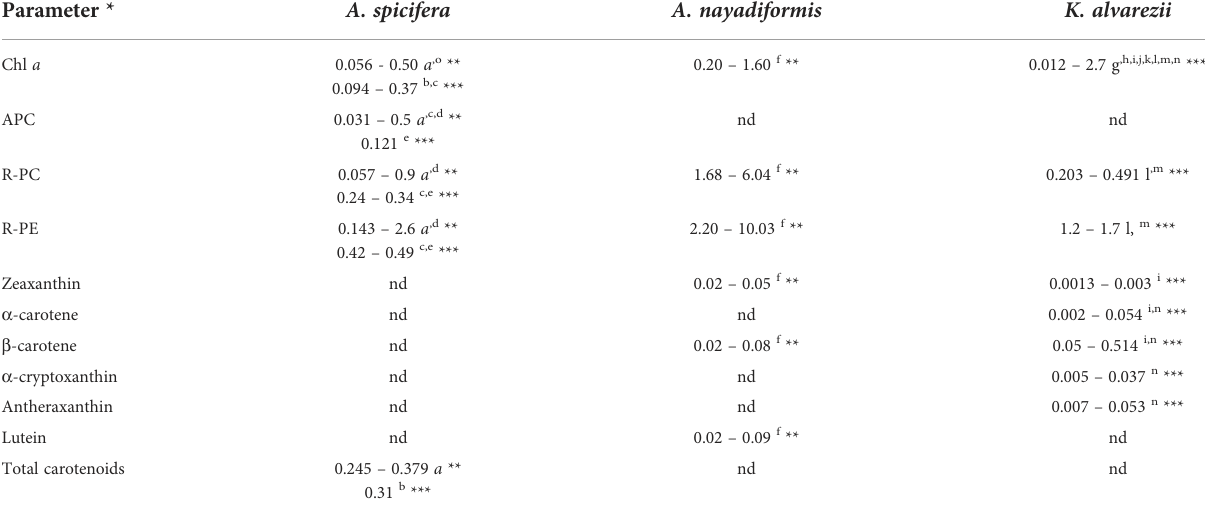
TABLE 5 Pigment content in Acanthophora and Kappaphycus